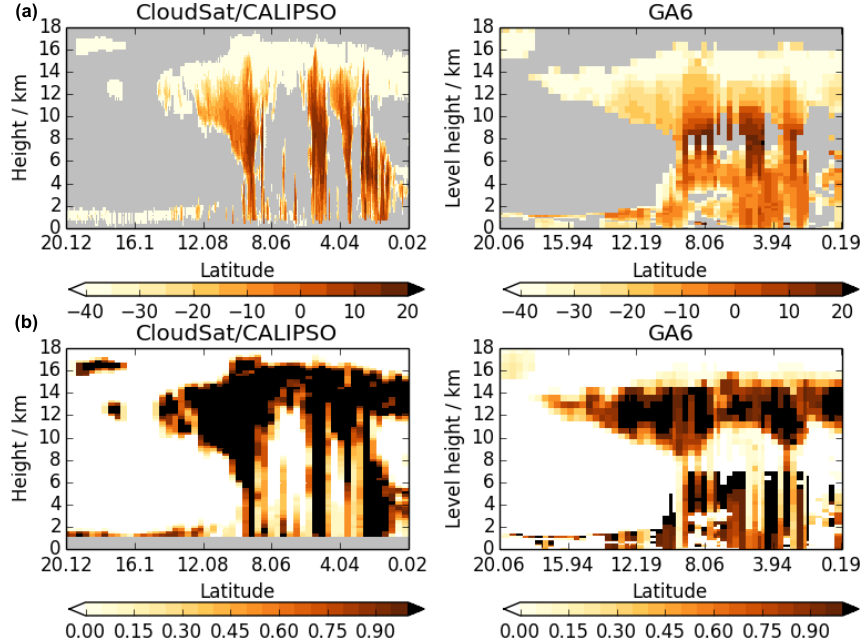
Figure 3. Case study of a GA6 6h forecast verifying at 18:00UTC on 17 December 2010 for an A-train pass over the South China Sea. (a) The observed and simulated radar reflectivities (dBZ) with situations in which the lidar detected cloud but the radar did not being included with a nominal value of − 40dBZ (e.g. Mace and Wrenn, 2013). (b) Observed and simulated cloud fraction on the model